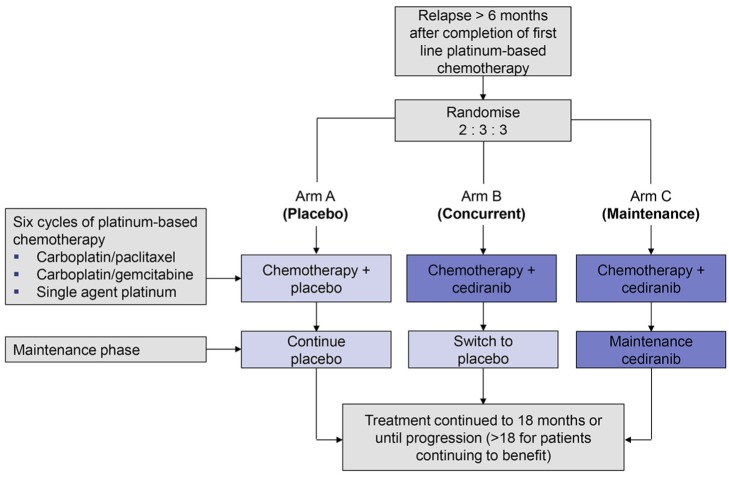
ICON6 trial design.